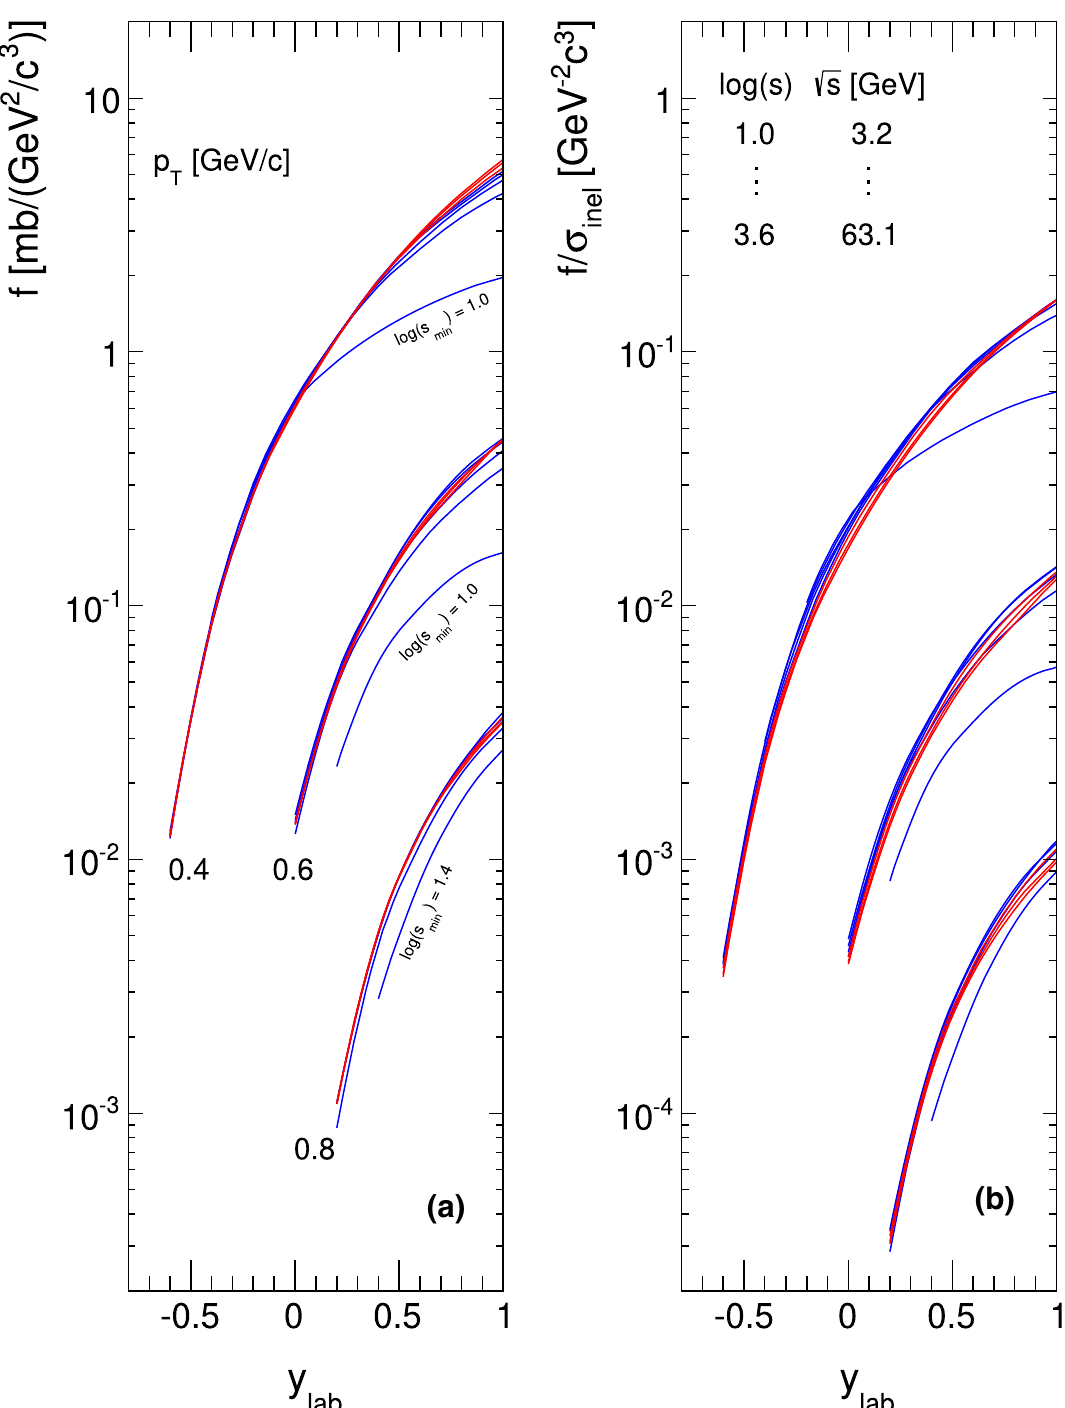
Fig. 108 π − cross sections as a function of y lab for p T = 0.4, 0.6, 0.8 GeV/c and different log ( s ) values in the range 1 < log s < 3.6; a f ( y lab , p T ) , b f ( y lab , p T )/σ inel . The distributions for different p T values are successively scaled down by factor of 1/3 for better